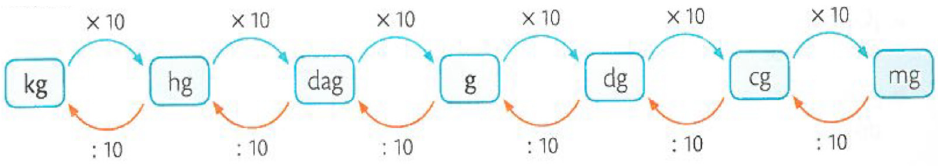
Figure 6. Unit of measure conversion (fourth year mathematics, SM [44]).